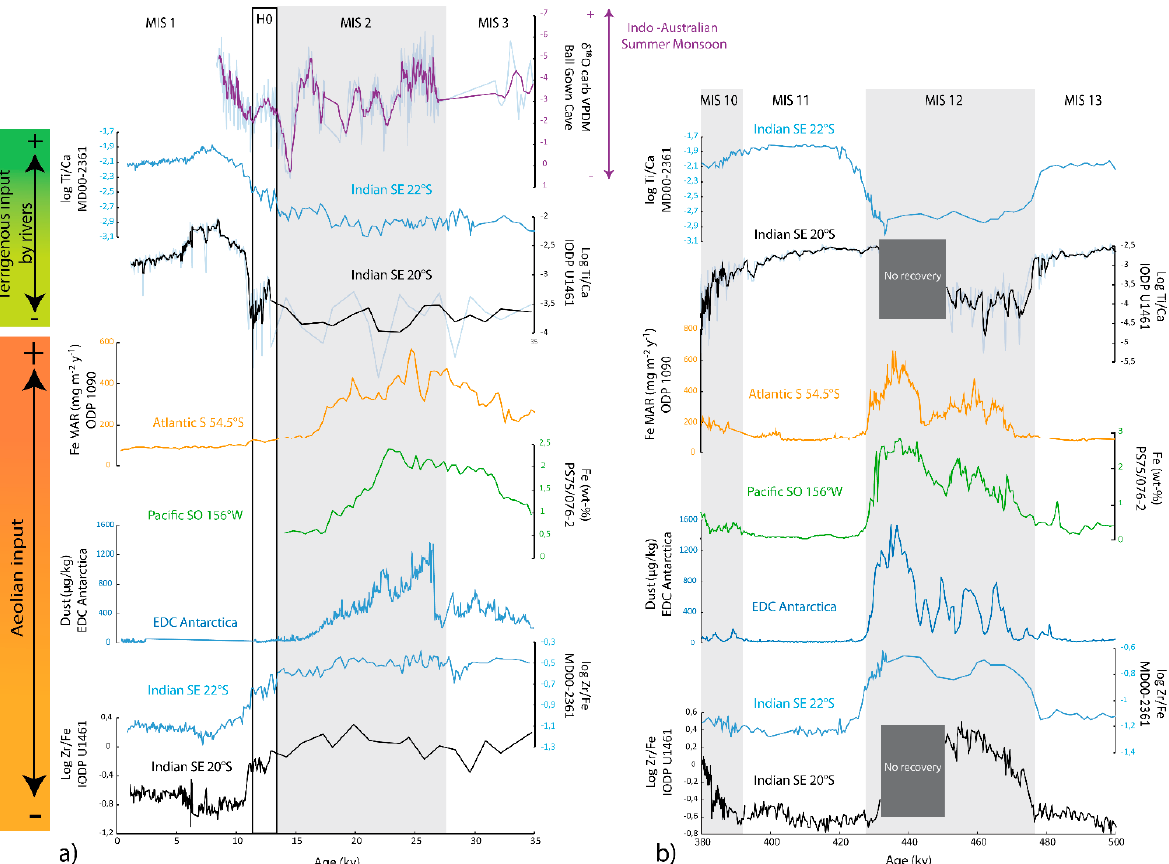
Figure 6. Synthesis and comparison of the data with the literature for the two targeted time periods. ( a ) MIS 1–MIS 3. ( b ) MIS 10-MIS 13. Comparison between Log(Ti/Ca) and Log(Zr/Fe) from the Site U1461 and the ones from the core MD00-2361 [12]. This figure also show proxy of dust abundance in other records from the Southern Hemisphere: Antarctica with the dust concentration in µg/kg from Epica Dome C [19], SO Pacific Ocean with the abundance of Fe (wt-%) in PS75/076-2 [17], and from South Atlantic with the Fe Mass Accumulation rate in mg − 1 m² y − 1 from the Site ODP 1090 [18]. For the period between MIS 1 and MIS 3 the δ 18 O values of the speleothem in the Ball Gown Cave [43] are shown. The correlation with Southern Hemisphere records is discussed in Sections 5.2 and 5.4.